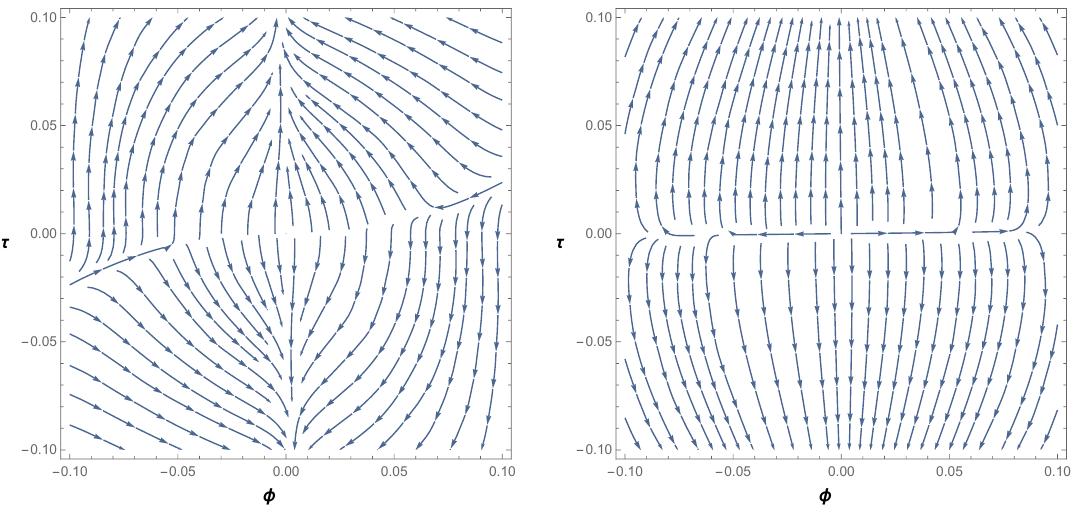
Figure 1 . The figure shows the stream-plots of the (negative) gradient of V at t = 0 . 1 (on the left hand side) and t = 1 (on the right hand side) restricted to the φ and τ directions, after consistently setting χ and σ to zero, for ξ UV = 1 . The origin has positive energy and has one tachyonic direction immediately, while a second tachyonic direction develops as early as t & 0 . 35 . The behaviour of the masses does not change for larger t